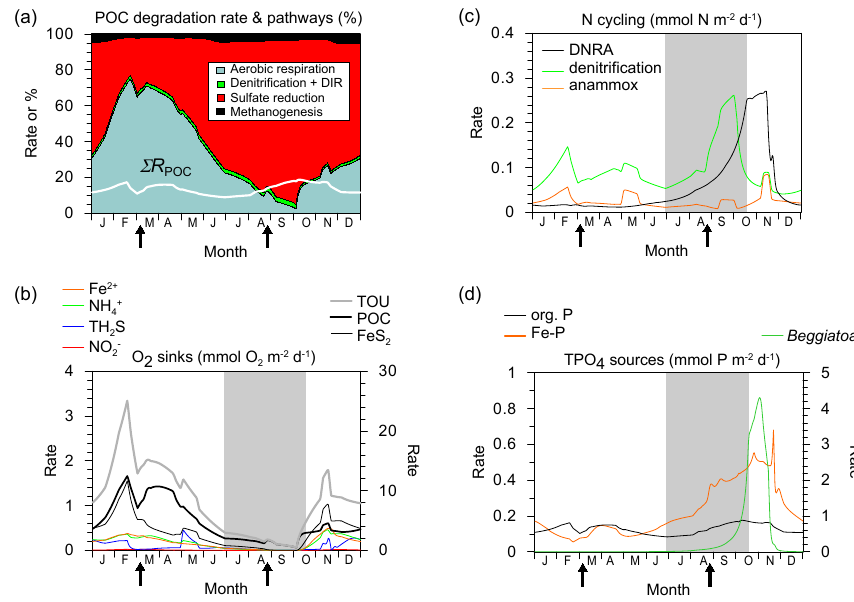
Fig. 6. (a) The daily fraction (%) of POM which is mineralized by each diagenetic pathway and the total rate of POM mineralization ( 6R POC in mmolm − 2 d − 1 of C shown by the white line). (b) Rates of O 2 consumption by different electron donors and TOU (mmolm − 2 d − 1 of O 2 ). (c) Selected N cycling pathways (mmolm − 2 d − 1 of N). Denitrification corresponds to the N 2 -producing pathway. (d) Biogeochemical reactions producing TPO 4 in the sediment (mmolm − 2 d − 1 of TPO 4 ). The period with hypoxic bottom water (O 2 < 63µM) is indicated with the grey shaded area and the black arrows indicate the start of the spring and autumn